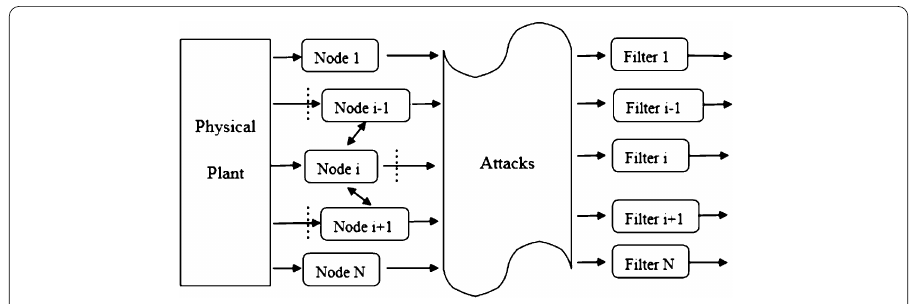
Figure 1 The DEKF problem under